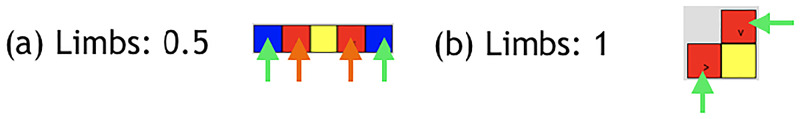
Morphology (a) has four modules that could be extremities (considering the limit determined by the size of the morphology), but only the two indicated by green arrows are; (b) has the maximum number of extremities it could have.